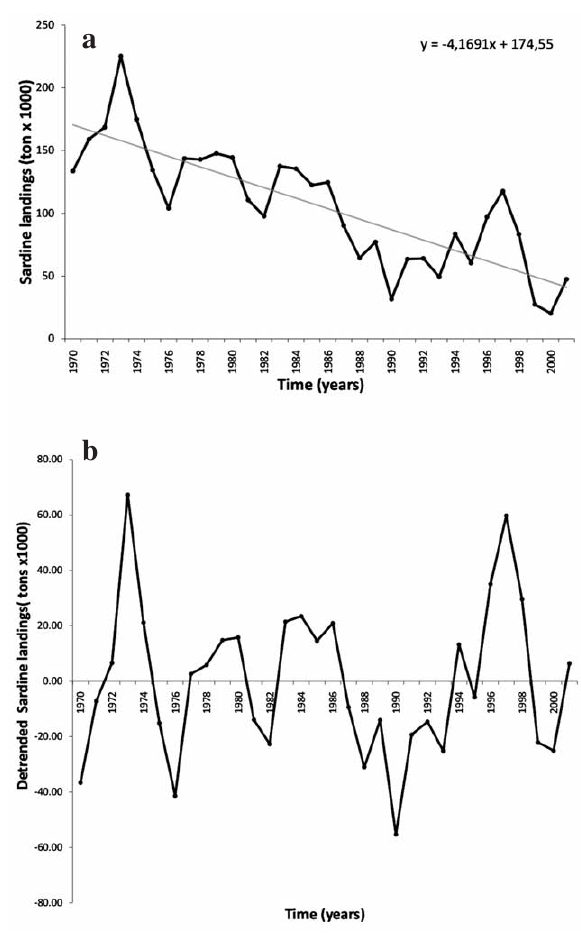
Fig . 2. – Total annual landings of the Brazilian sardine: a) linear trend in data; b) detrended time